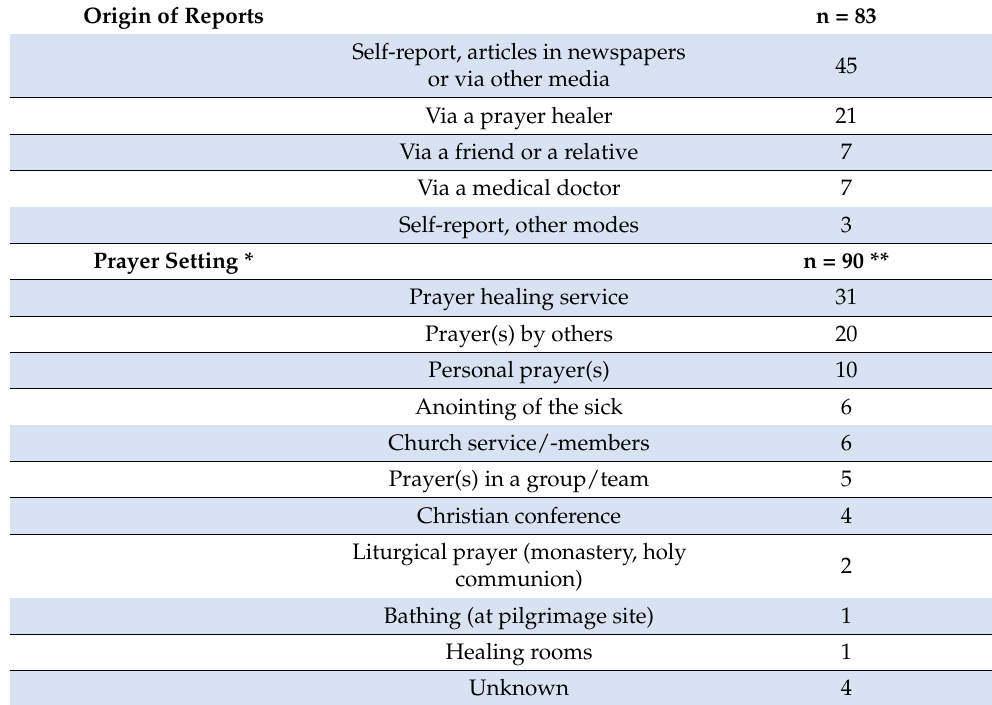
Table 4. Origin of reports, Prayer setting of prayer(s) associated with